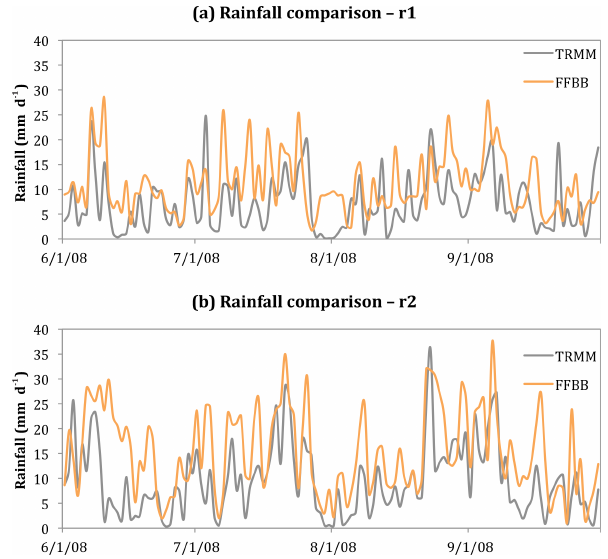
Figure 3. Time series of area-averaged daily rainfall (mmd − 1 ) from the Tropical Rainfall Measuring Mission (TRMM) and FFBB over (a) the Sumatra region (r1) and (b) the Borneo region